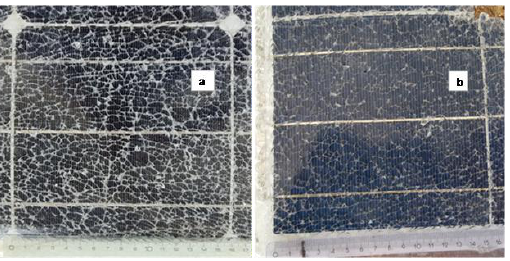
Figure 1. Pieces of: ( a ) m-Si and ( b ) p-Si panels after removing the aluminum frames.